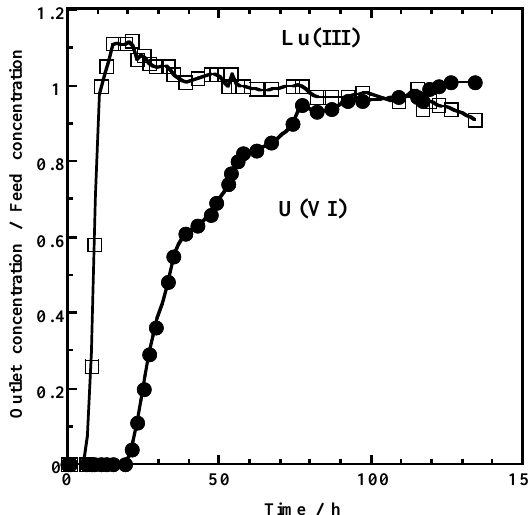
Figure 3. Breakthrough profile of uranium(VI) and lutetium(III) from the column packed with persimmon peel (PP) gel.